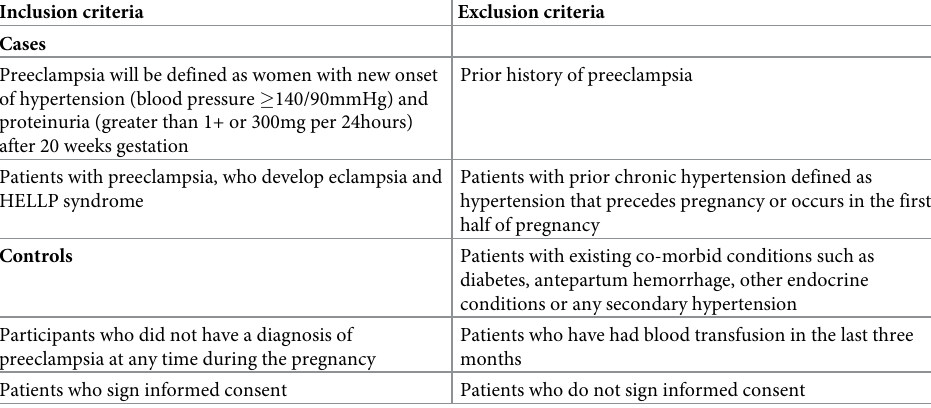
Table 1. Inclusion and exclusion criteria.